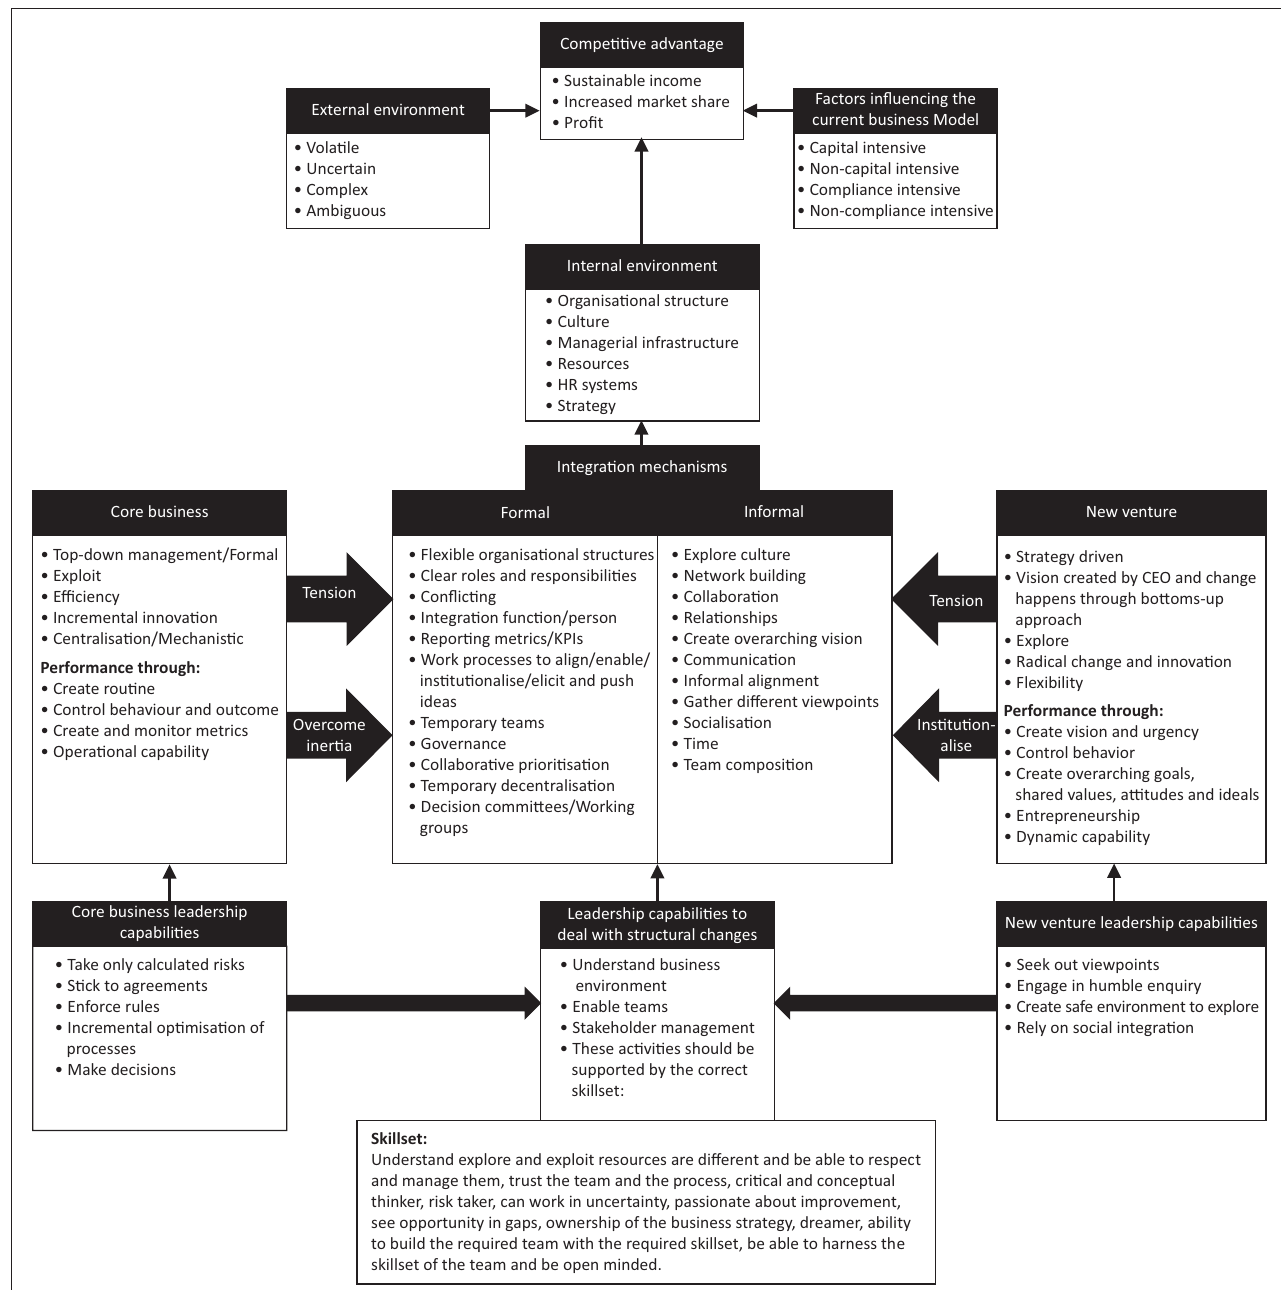
FIGURE 2: Framework of leadership capabilities to support structural